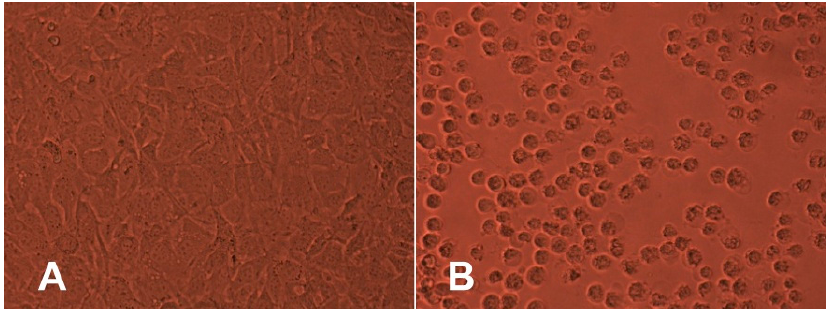
Figure 2. Sample PCL-1: ( A ) no detectable zone around or under specimen; ( B ) positive control zone with degenerated cells extending up to 0.7 cm around the specimen. Magnification × 200.